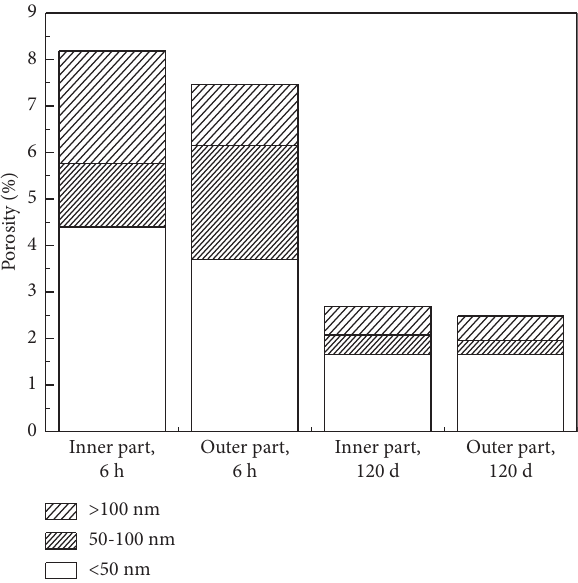
Figure 7: The porosity of hardened cement